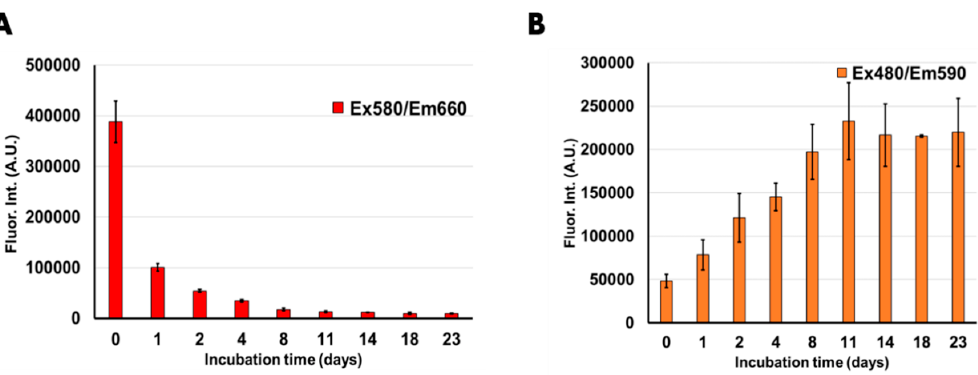
Figure 3. The relative emission intensity of ( A ) DNA 6C-27a-3bp/AgNCs and ( B ) DNA 6C-217- 11bp/AgNCs over 23 days with Ex/Em of 580/660 nm and 480/590 nm respectively. Day 0 refers to the measurement of fluorescence emission after 1hr of synthesis. All the DNA/AgNCs samples